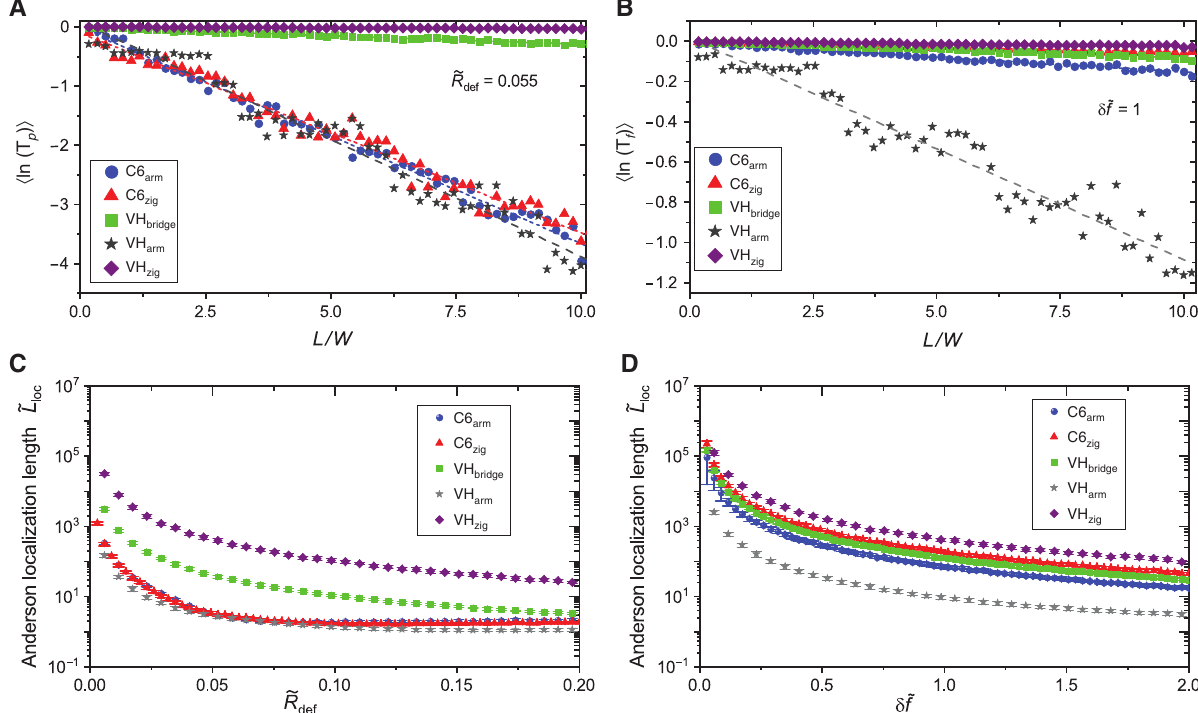
Figure 4: Statistical analysis of the robustness of topological subwavelength-guiding systems in the presence of position and frequency disorder: the C6 - based waveguides with armchair (blue circles) and zigzag (red triangles) interfaces, VH-based waveguides with bridge (green squares), armchair (gray stars) and zigzag (purple rhombs)